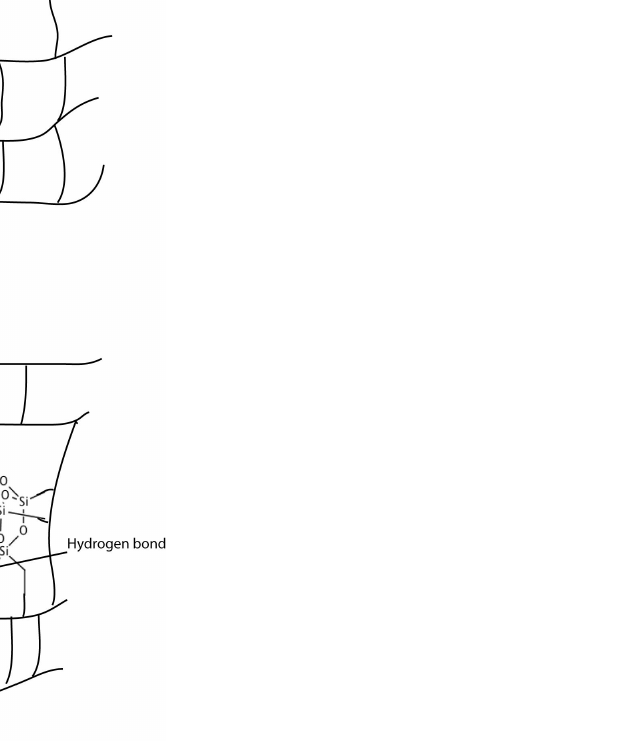
Figure 2. Figure shows molecular network without ( a ) and with ( b ) POSS molecule. Inclusion of POSS in the epoxy network increases the free volume that contributed in increase of ductility